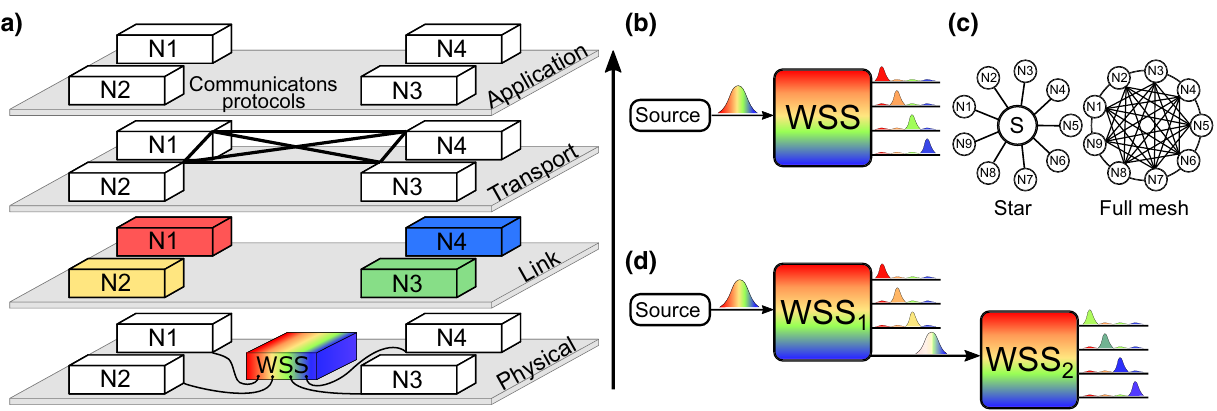
FIG. 1. (a) QLAN communication layers and services. The physical layer includes the optical components where the photons travel and are manipulated, the link layer slices the spectrum and routes each slice to a particular user, the transport layer is the quantum- correlated network where a pair of users shares entanglement, and the application layer uses the entangled pairs to perform a service. (b) Single WSS configuration: the input spectrum is sliced and routed to the output ports. (c) Comparison of physical (star) and logical (fully connected mesh) topologies in network design. (d) Nested WSSs where a portion of the spectrum is routed from the first to the second WSS, thereby expanding the number of nodes connected by the entanglement